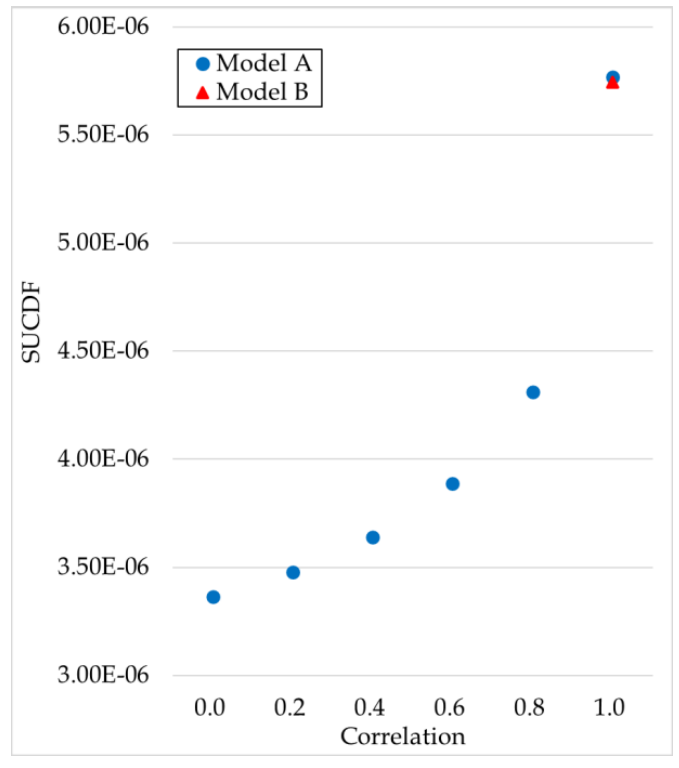
Figure 12. Plots of SUCDF versus seismic correlation.